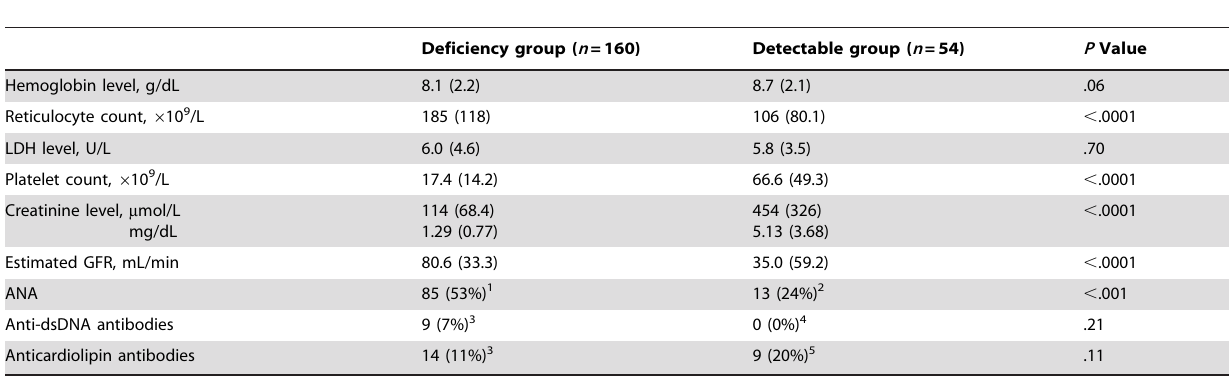
Table 2. Results of Laboratory Testing in 214 Patients with Thrombotic Microangiopathy According to ADAMTS13